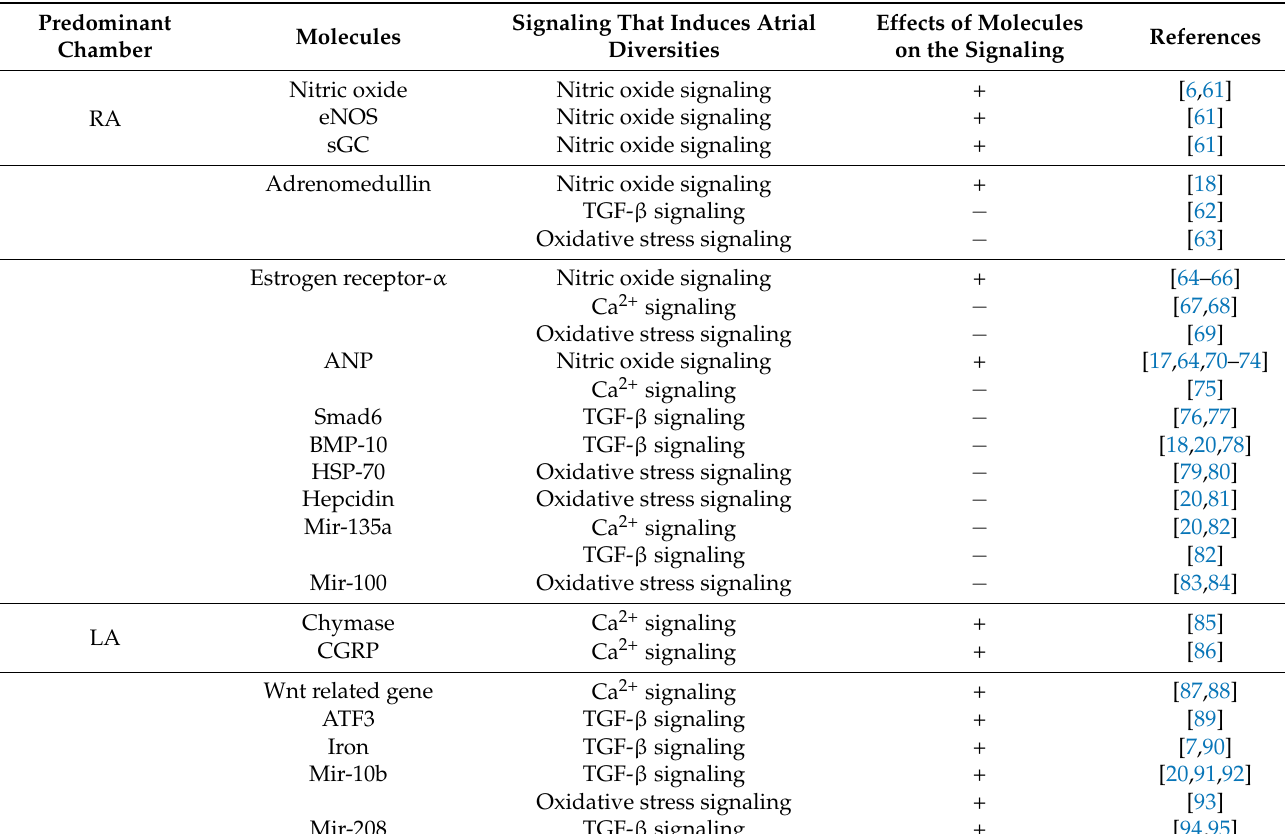
Table 1. List of targets that activate the atrial regional diversities in